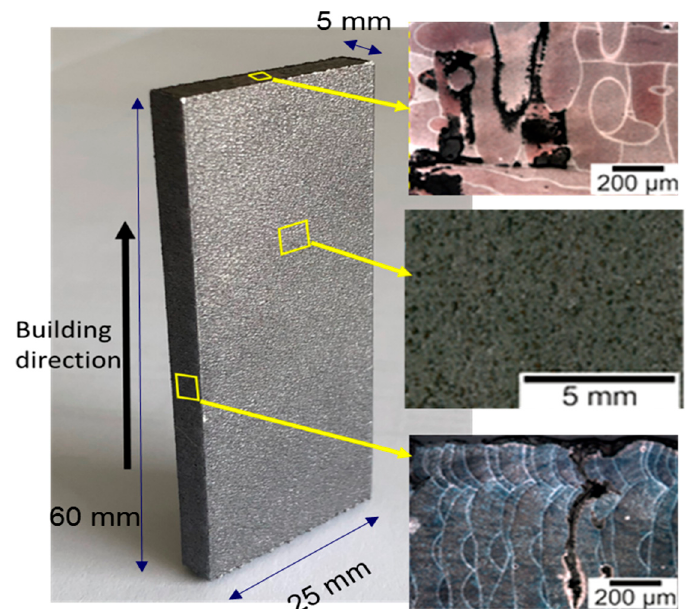
Figure 5. As-built SLM sample after corrosion testing. Left: Macroscopic documentation; Right: Cross-section perpendicular to build direction (top), corrosion attack at the large surface (middle), corrosion attack in the smaller surface (bottom).